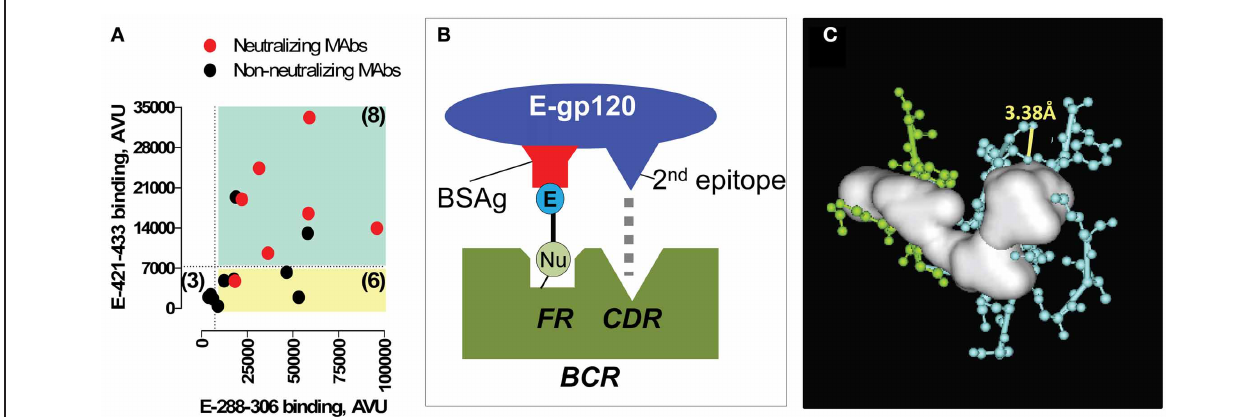
FIGURE 7 | Monoclonal antibodies (MAbs) raised to E-gp120. (A) Epitope specificity-neutralizing activity relationships. Anti-E-gp120 MAbs frequently display binary E-288–306 and E-421–433 binding. Binding of E-288–306 and E-421–433 by 17 MAbs wasmeasured. Plotted are band intensities (in arbitrary volume unit, AVU) of the adducts formed by individual MAbs. Cyan quadrant contains MAbs with adduct densities at least 4-fold greater than the background mean band intensity of adducts formed by the irrelevant control E-peptide probes (binary peptide binding MAbs). Yellow quadrant contains monoreactive MAbs to E-288–306. Red symbols denote MAbs that neutralized subtype C strain 97ZA009 (IC 50 < 20 μ g/mL); black symbols, non-neutralizing